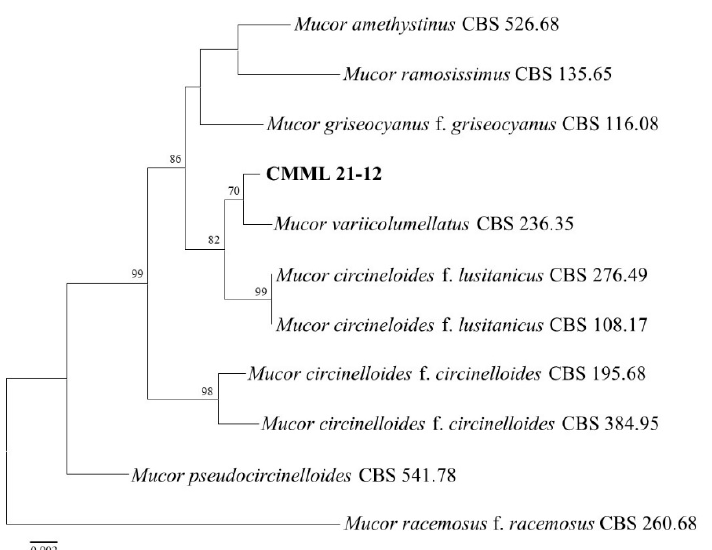
Figure 5. The maximum likelihood tree of the Mucor isolates (CMML21–12) was inferred from the combined datasets of the ITS, LSU, and SSU gene sequences constructed by the MEGA X program. The tree is rooted to Mu. racemosus f. racemosus CBS 260.68. The number on branches indicates the bootstrap values. The scale bar indicates expected changes per site. The isolates from the present study are indicated in bold.